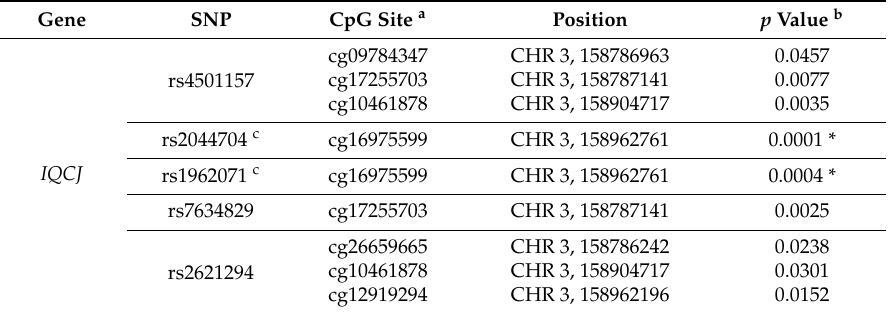
Significant associations of tagged single-nucleotide polymorphisms (SNPs) from genome-wide association study (GWAS)-associated genes with pre-supplementation methylation levels ( n = 35